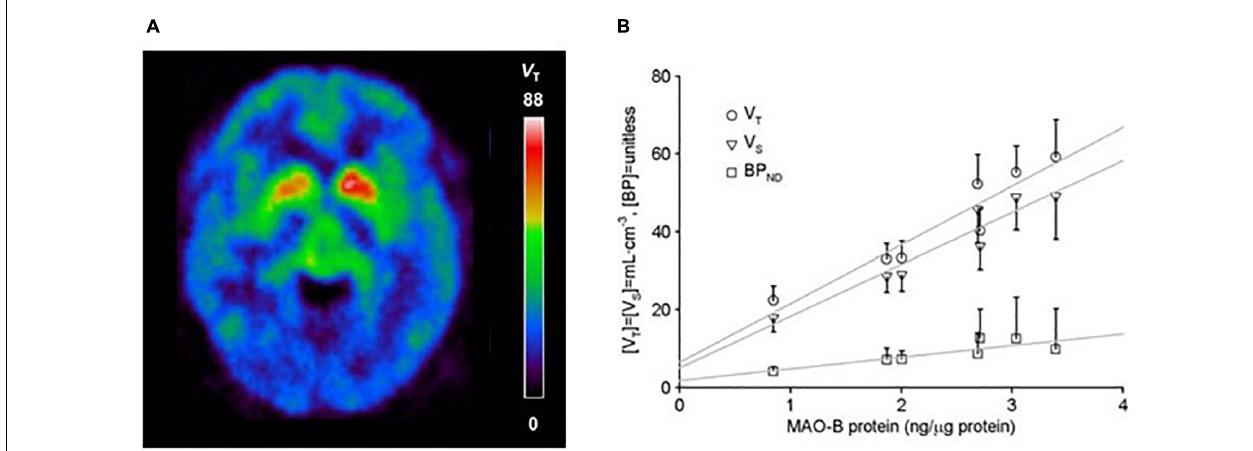
FIGURE 3 | (A) [ 11 C]SL25.1188 uptake in the human brain. Adapted with permission from Moriguchi et al. (2019). Copyright © (2019) American Medical Association. All rights reserved. (B) Relationship between regional average in vivo [ 11 C]SL25.1188 V T , V S , and BP ND ( n = 14) and in vitro concentration of monoamine oxidase B (MAO-B) determined by immunoblotting in autopsied normal human brain ( n = 6). Brain regions include cerebellar cortex, prefrontal cortex, temporal cortex, putamen, anterior cingulate cortex, thalamus, and caudate in order of increasing MAO-B protein concentrations. Dark lines represent SD. Linear fit analysis, V T : r 2 = 0.9; V S : r 2 = 0.92; BP ND : r 2 = 0.7 (note V T conventionally applied as index of MAO-B protein level). Adapted with permission of SAGE Publications from Rusjan et al. (2014). Copyright © (2014)